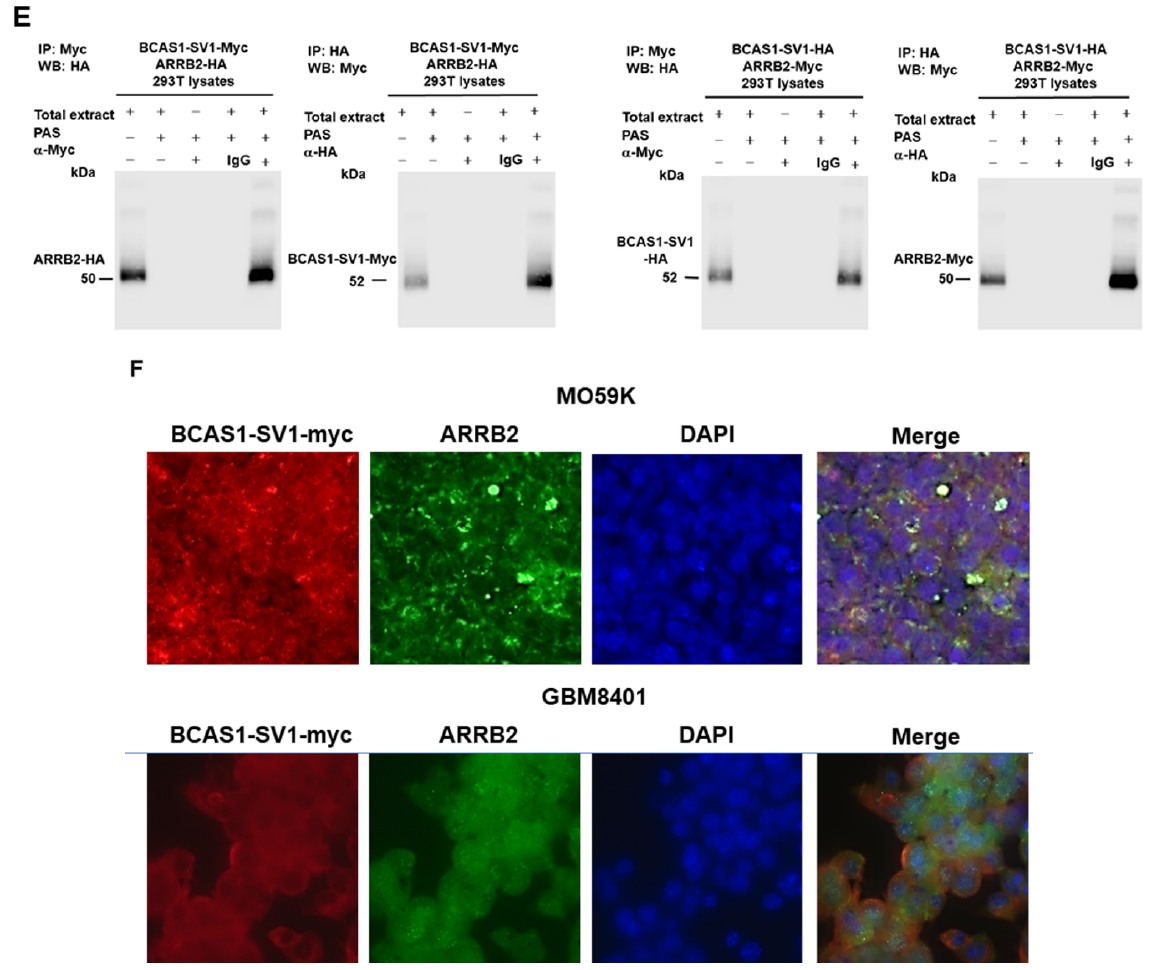
Figure 4. β -arrestin 2 ( ARRB2 ) specifically interacts with BCAS1-SV1 in vivo. ( A ) Schematic drawing of yeast two-hybrid screening. β -arrestin 2 clones were isolated by yeast two-hybrid screening of a human brain cDNA library using BCAS1-SV1 as bait. The AH109 strain was transformed with the construct containing BCAS1-SV1 fused in-frame to the Gal4 DNA-binding domain ( B , D ) and then mated with the Y187 strain, which contain plasmid with the human brain cDNA library fused to the activation domain of Gal4 ( A , D ). The reporter genes of diploid cells were activated in response to two-hybrid interactions and were selected on SD/ − Ade/ − His/ − Leu/ − Trp/X- α -gal plates. ( B ) Positive colonies of yeast two-hybrid screening are shown. Diploid cells (blue) contain four reporter genes that are activated in response to the two-hybrid interactions. ( C ) Schematic drawing of the overlapping ARRB2 cDNA clones that span the coding region of the ARRB2 gene (NCBI reference sequence: NP_004304.1) ( D ) Interaction between BCAS1-SV1 and full-length β -arrestin 2 in yeast two-hybrid assay. Diploid cells containing BD-p53 and AD-T were used as a positive control. ( E ) BCAS1-SV1 interacts with β -arrestin 2 in an immunoprecipitation analysis. Cell extracts prepared from 293T cells co-transfected with Myc-tagged BCAS1-SV1/HA-tagged ARRB2 plasmids or Myc-tagged ARRB2/HA-tagged BCAS1-SV1 plasmids were subjected to immunoprecipitation and Western blot analysis using anti-HA antibody or anti-Myc antibody. ( F ) BCAS1-SV1 and β -arrestin 2 are partially co-located in M059K and GBM8401 cells. BCAS1-SV1 and β -arrestin 2 were observed by immunofluorescence staining. The green spots represent ARRB2. The red spots represent BCAS1-SV1-Myc. The nuclei were stained with DAPI (blue).